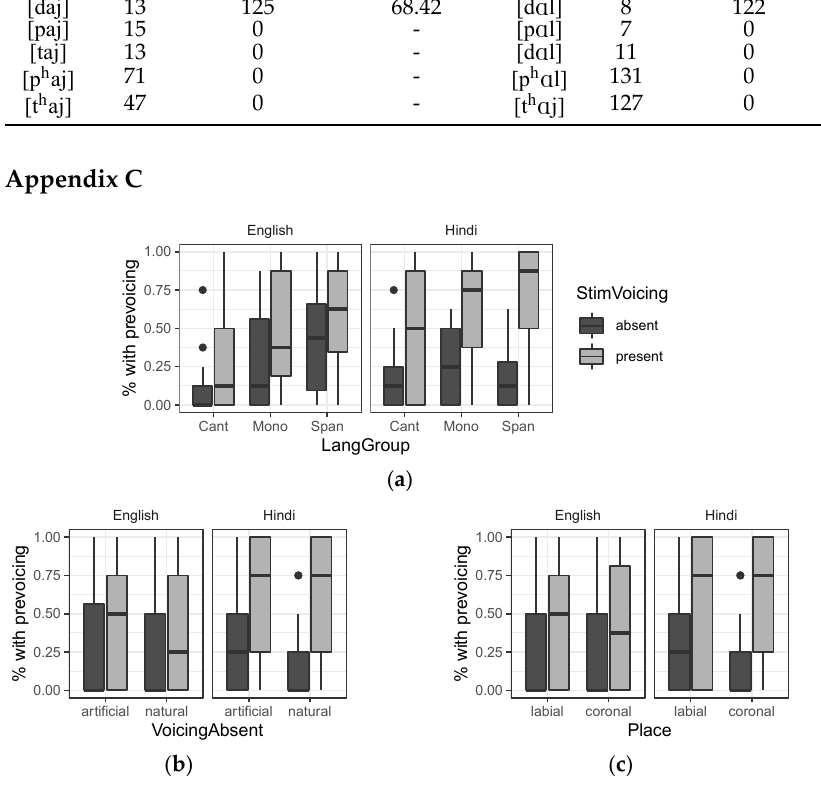
Figure A1. Distribution of by ‐ participant mean percentage of voicing in stimuli where prevoicing was absent (dark grey) or present (light grey), broken down by Stimulus Language (left vs. right panels) and ( a ) Language Group, ( b ) VoicingAbsent Type, and ( c ) Place of Articulation.